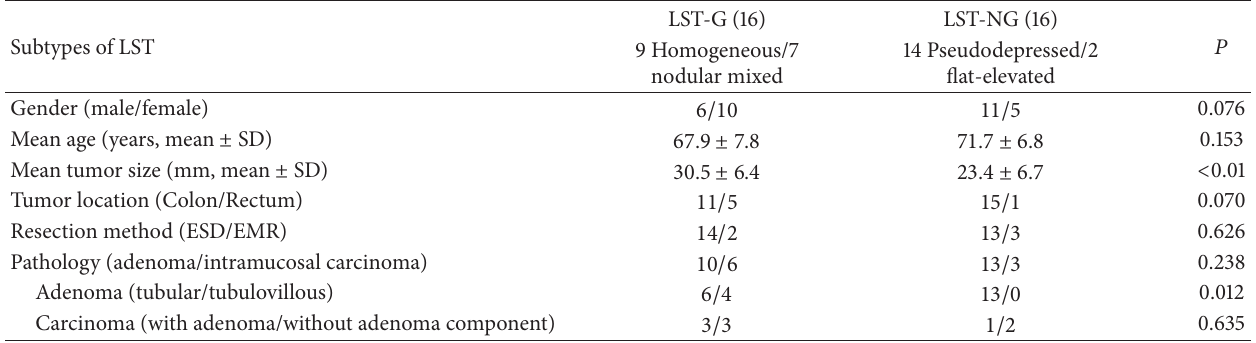
Table 2: Clinicopathological features of patients with laterally spreading tumor included in this study ( 𝑛 = 32 ).